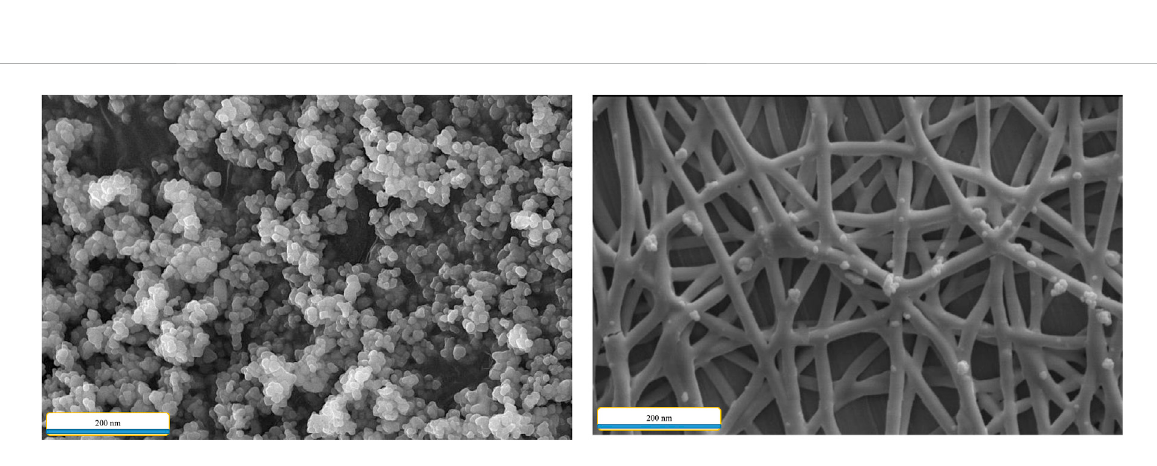
FIGURE 1 SEM image of (I) cobalt composite and (II) CCPSF